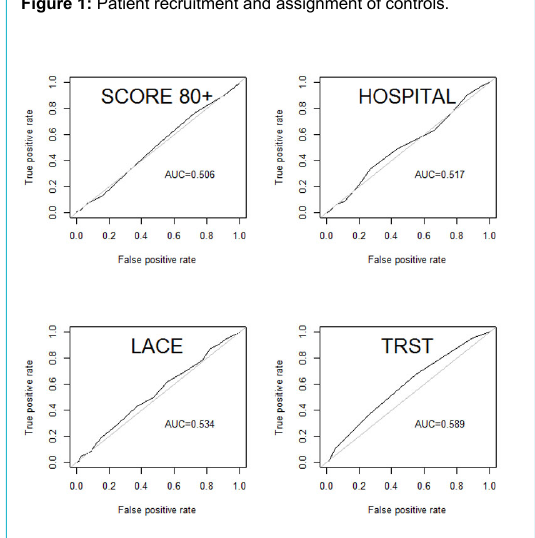
Figure 1: Patient recruitment and assignment of controls.